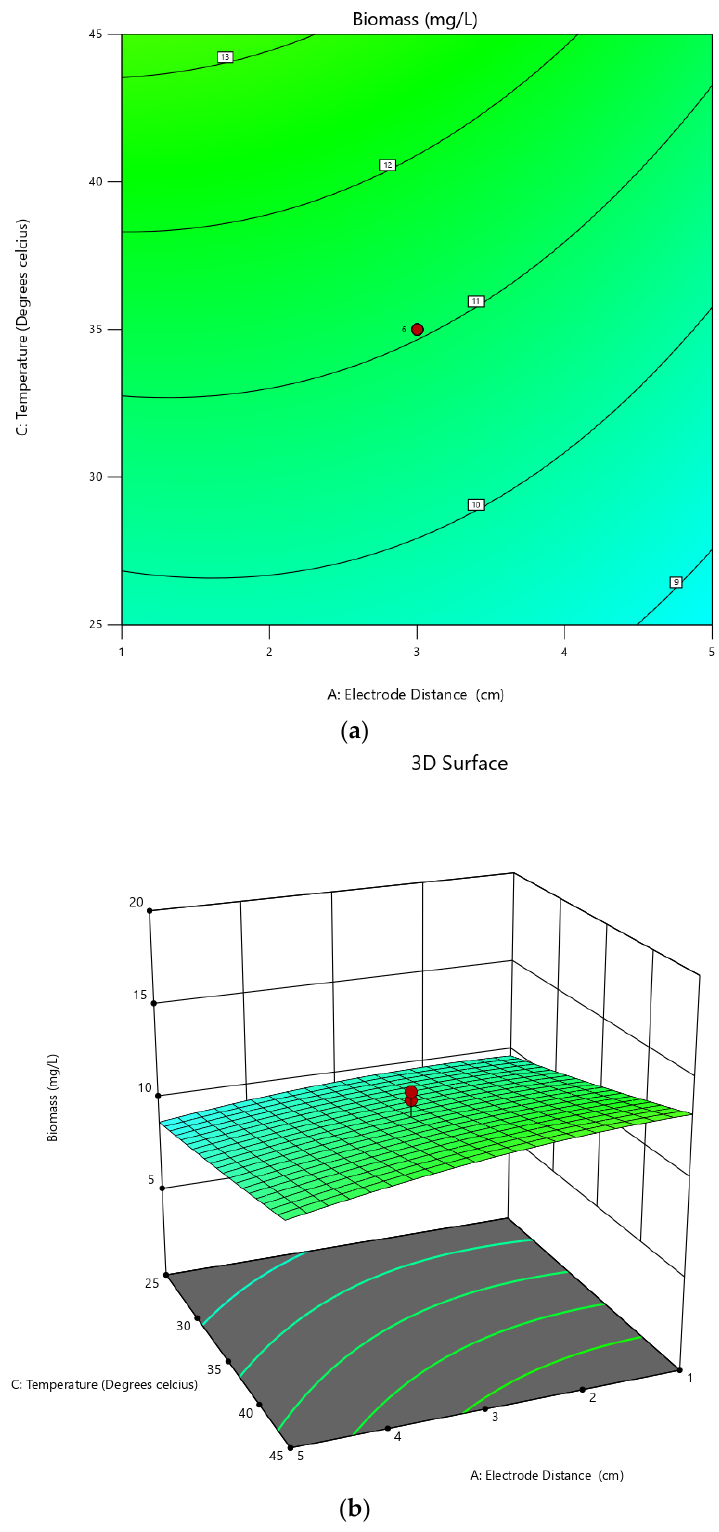
Figure 4. ( a ) Contour plot and ( b ) response surface plot of biomass as a function of temperature relative to electrode distance.